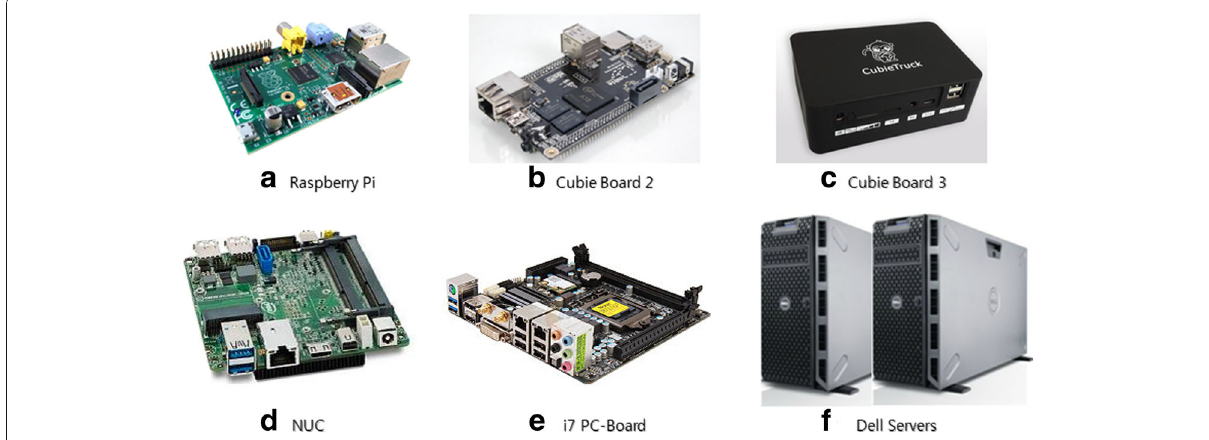
Fig. 5 HW platform testbed of the PBX SW Asterisk. a Raspberry Pi. b Cubie-Board 2. c Cubie-Board 3. d NUC. e i7 PC board. f Dell